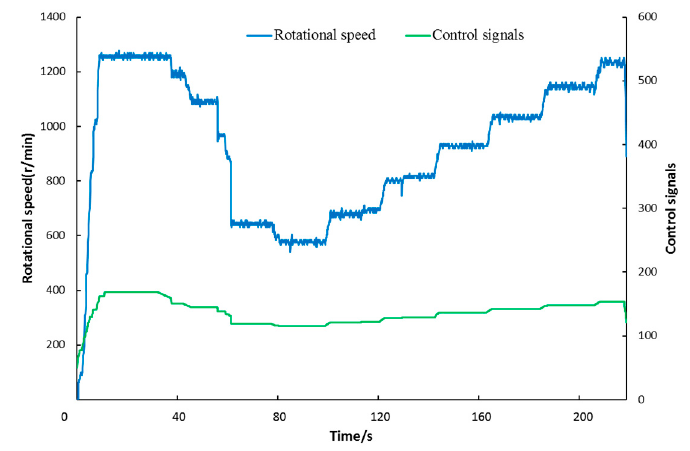
Figure 9. Automatic adjustment of pulling rollers under no load.